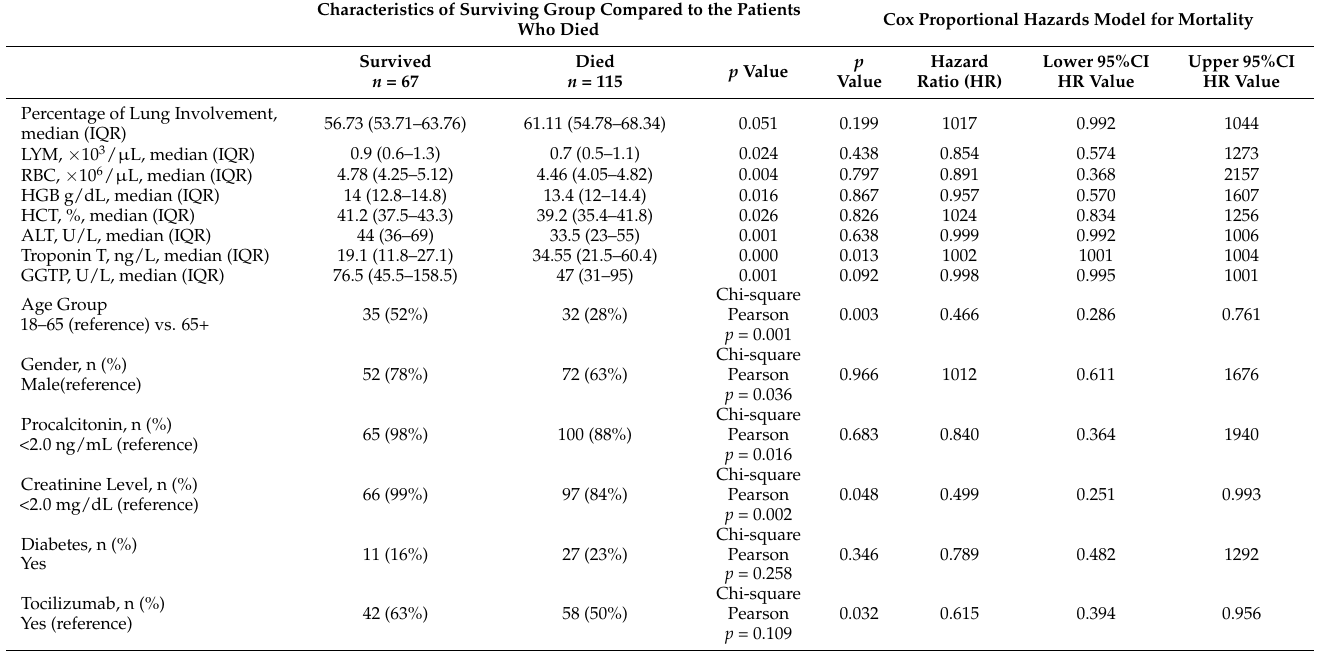
Table 3. Characteristic of surviving group compared to the patients who